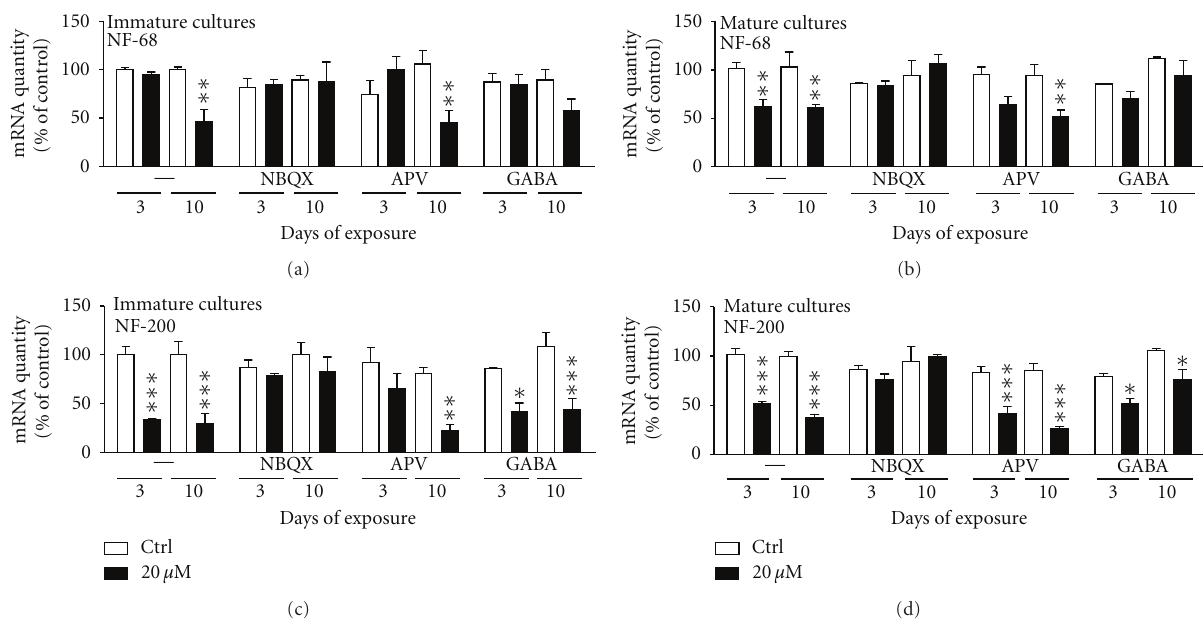
Figure 4: Changes in the mRNA levels of NF-68 and 200 in primary cultures of CGCs exposed to 20 μ M domoic acid alone or in combination with antagonists for the AMPA-R (NBQX, 20 μ M), NMDA-R (APV, 100 μ M) or the neurotransmitter GABA (10 μ M) at 1 DIV (immature cultures) or at 7 DIV (mature cultures) for 3 or 10 days. Note that NBQX but not APV prevent the domoic acid-induced downregulation of (a) NF-68 in immature cultures, (b) NF-68 in mature cultures, (c) NF-200 mRNA expression in immature cultures, and of (d) NF-200 in mature cultures. Gene expression levels were normalized to the standard calibrator, the housekeeping gene 18S rRNA and the mRNA expression at 1 DIV. Data represent mean ± S.E.M. of three independent experiments performed in duplicates. ∗ P < 0 . 05 ∗∗ P < 0 . 01 ∗∗∗ P < 0 . 001 comparing treated to control (untreated)